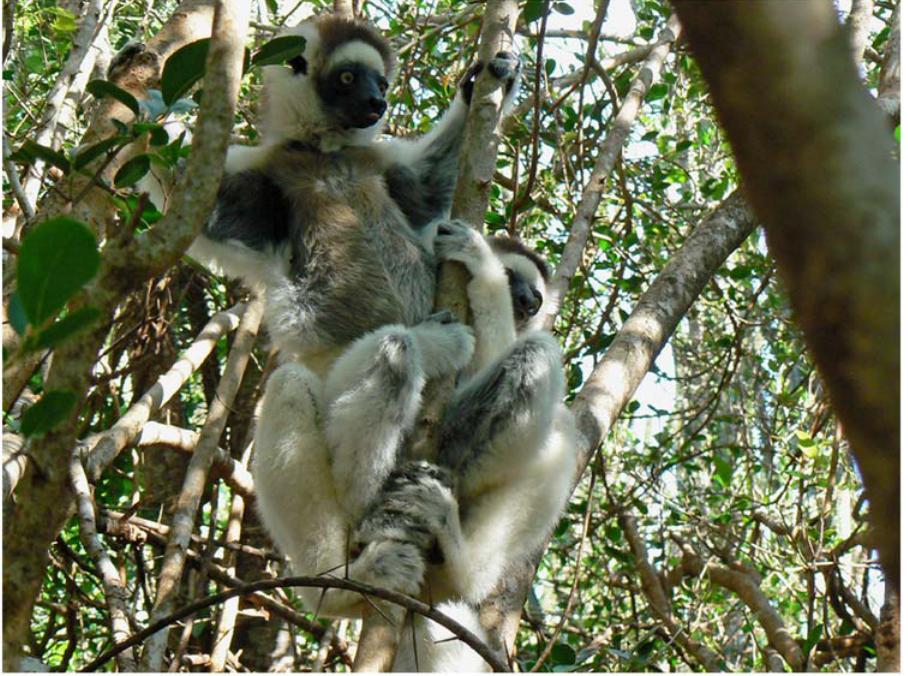
Figure 1. Sifaka copulation: picture taken during a mating episode. Photo by Daniela Antonacci via Panasonic Lumix DMC FZ7 - 12 6 optical zoom/36–432 mm equivalent/LEICA lens.